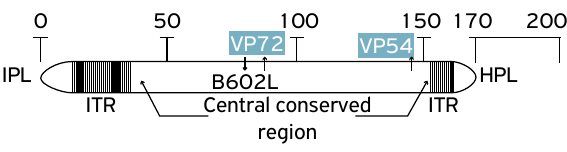
Figure 2. Simplified scheme of the African swine fever virus genome based on the sequence of the non-pathogenic BA71V strain (YANES et al., 1995). The scheme indicates the location of genes that code for vp72 and vp54 proteins and the B602L gene. Number indicate kilobase pairs (kbp). Adapted from YANES et al.